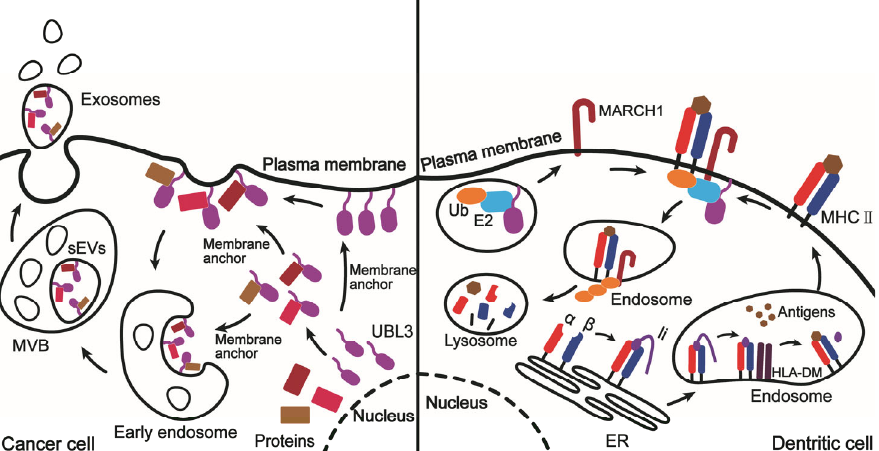
Figure 1. Model diagram of Ubiquitin ‐ like protein 3 (UBL3) function. Left part: Proteins are modified with UBL3, which is free or membrane ‐ anchored (exact mechanism of modification is not clear). The modified proteins are recruited into the endosomes, forming multivesicular bodies (MVBs) containing small extracellular vesicles (sEVs), and sEVs are secreted out of the cell. Right part: major histocompatibility complex class II (MHC II) α and β chains are assembled and complexed with Ii in the endoplasmic reticulum (ER). Upon entry into the endosome, Ii is degraded to class II ‐ associated invariant chain peptide (CLIP). HLA ‐ DM catalyzes the release of CLIP and binding of antigen. The stable antigen–MHC II complex is transferred to the cell surface to present the antigen to T cells. UBL3 recruits a Ub ‐ E2 enzyme to the membrane and promotes ubiquitination of MHC II by membrane ‐ associated RING ‐ CH (MARCH) 1, a Ub ‐ E3 ligase, and then MHC II is targeted into the lysosome for degradation.